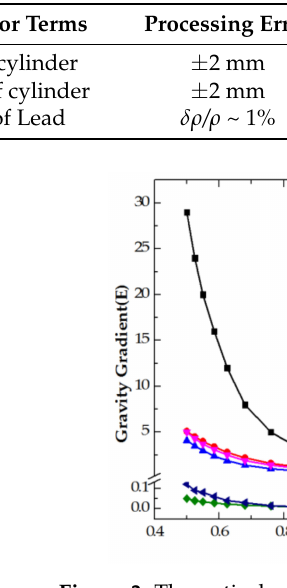
Figure 3. Theoretical calculation curve of gravity